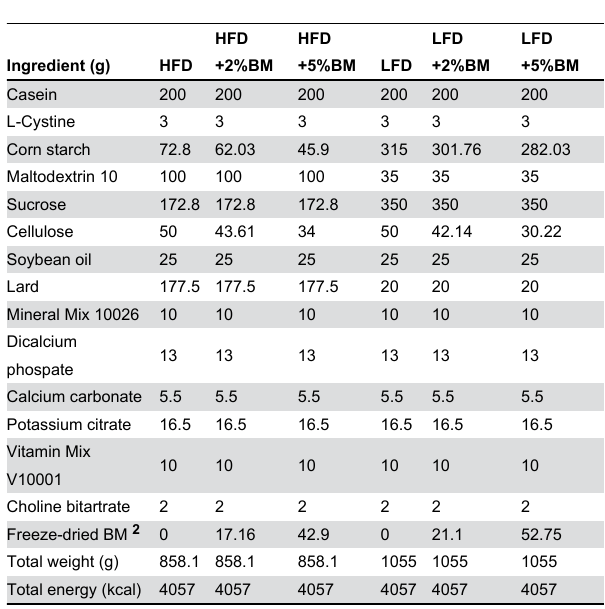
Table 1. The composition of diets used in experiment 1